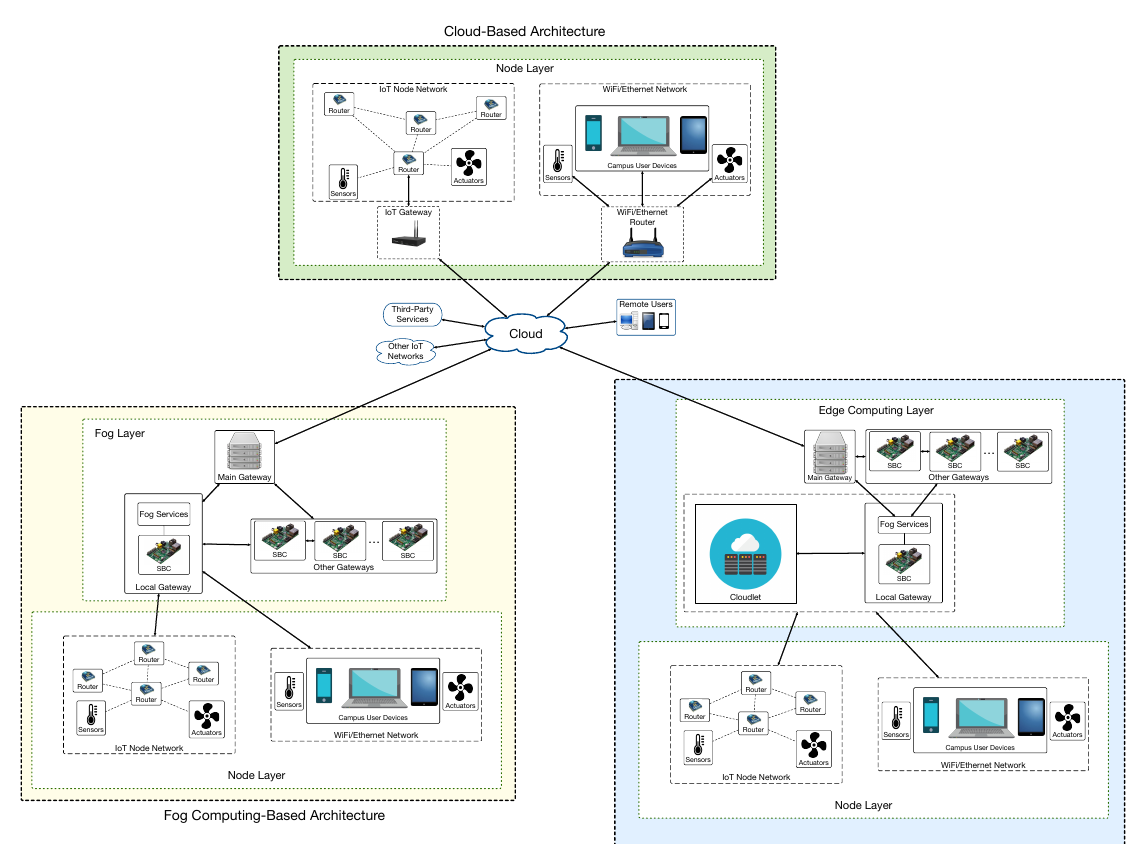
Figure 2. Smart campus architecture